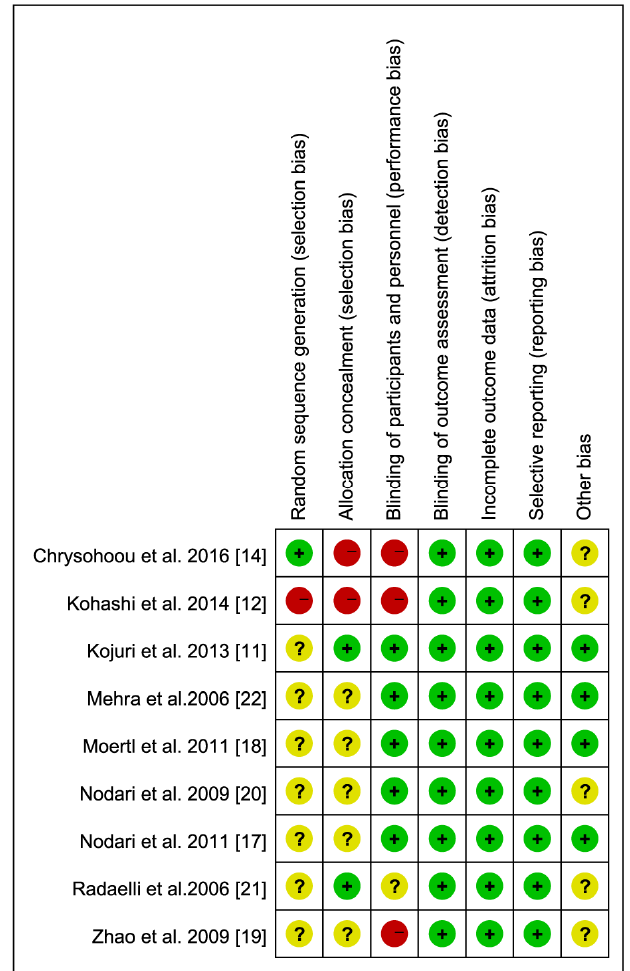
Figure 2. Risk of bias summary: Review authors’ judgements about each risk of bias item for each included study.